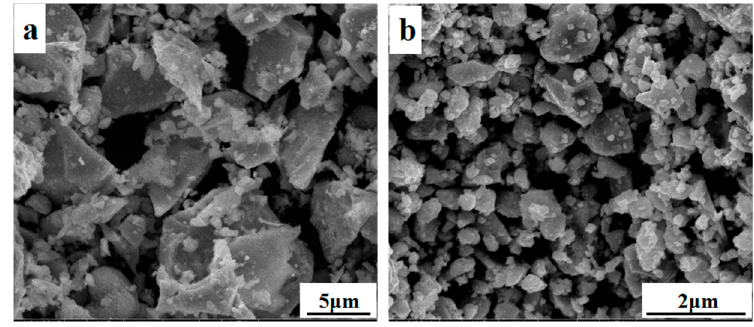
Figure 2. SEM images of Cu 2 SnSe 3 powder: ( a ) before ball milling; ( b ) after ball milling.